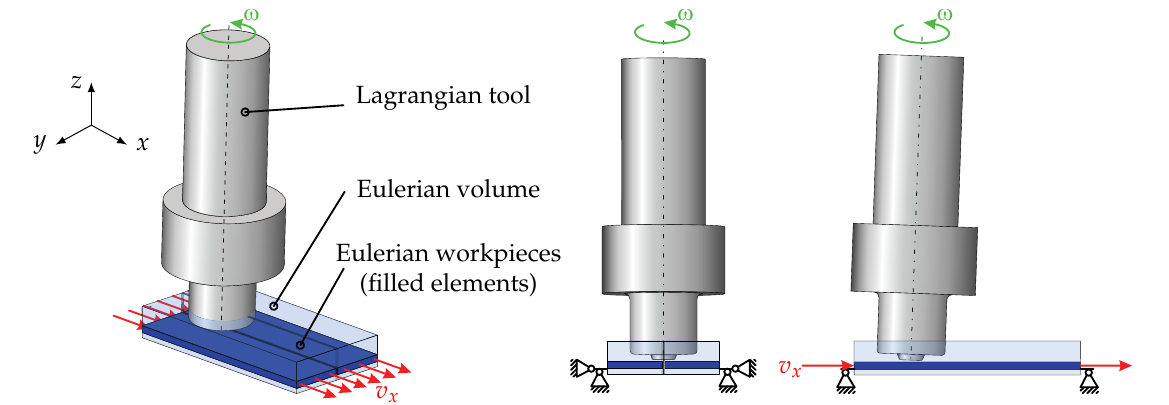
Figure 4. Schematic setup of the numerical model (starting position): isometric, front and side view, shown without tool holder, backing and clamping.